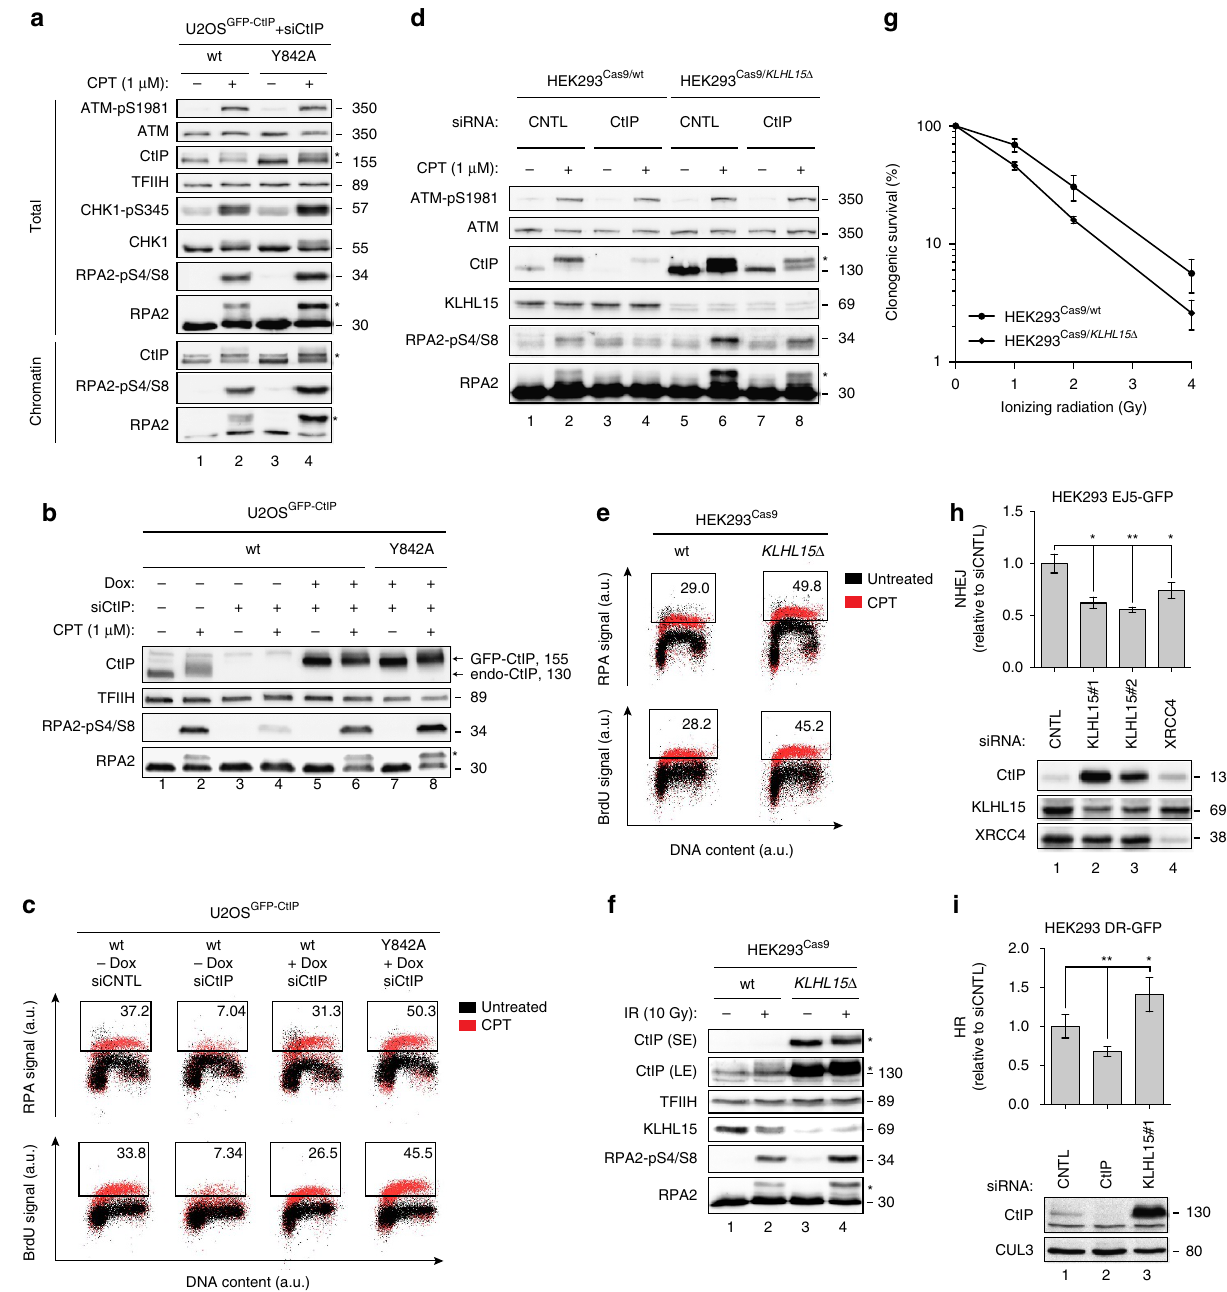
Figure 7 | KLHL15-dependent CtIP ubiquitination governs DNA-end resection and DSB repair pathway choice. ( a ) U2OS cells stably expressing doxycycline (Dox)-inducible siRNA-resistant GFP-CtIP-wt or GFP-CtIP-Y842A were transfected with CtIP siRNA. 24h later, GFP-CtIP expression was induced with Dox. Forty-eight hours post siRNA-transfection, cells were either mock-treated or treated with CPT (1 m M) for 1h. Total cell extracts and chromatin-enriched fractions were analysed by immunoblotting. ( b ) Same cells as in a were transfected with the indicated siRNA oligos. One day later, GFP-CtIP expression was induced for 24h and cells were treated with CPT for 1h before western blot analysis. ( c ) Same cells as in b were simultaneously labelled with BrdU (30 m M). 48h post siRNA-transfection, cells were treated with CPT for 1h, immunostained with anti-RPA2 or anti-BrdU antibody and analysed by FACS. Dot plots represent the intensity of the signals for RPA2 or BrdU staining ( y axis) against the DNA content ( x axis). Quantification gates were established in untreated samples and the percentage of cells within the gates are indicated. ( d ) HEK293 Cas9/wt and HEK293 Cas9/ KLHL15 D cells were transfected with the indicated siRNA oligos. Forty-eight hours later, cells were treated with CPT for 1h and analysed by immunoblotting. ( e ) Same cells as in d were processed for FACS analysis as in c . ( f ) Same cells as in d were irradiated at 10Gy and 3h later analysed by immunoblotting. SE and LE denote short and long exposures of the same membrane. ( g ) Same cells as in d were irradiated with increasing doses of IR and survival was determined by colony-formation assay. Data are presented as the mean ± s.d. ( n ¼ 4). ( h , i ) HEK293 EJ5-GFP or DR-GFP cells were transfected with the indicated siRNAs. Two days later, cells were transfected with the I-SceI expression plasmid and harvested after 48h for flow cytometry and immunoblot analysis. Data in h and i are represented as mean ± s.e.m. ( n ¼ 3) and as mean ± s.d. ( n ¼ 4), respectively. Unpaired, two-tailed t -tests were performed and P values expressed as *( P o 0.05) and **( P o 0.005) were considered significant. Asterisks indicate hyperphosphorylated forms of CtIP and RPA2. A.u., arbitrary units; FACS, fluorescence-activated cell